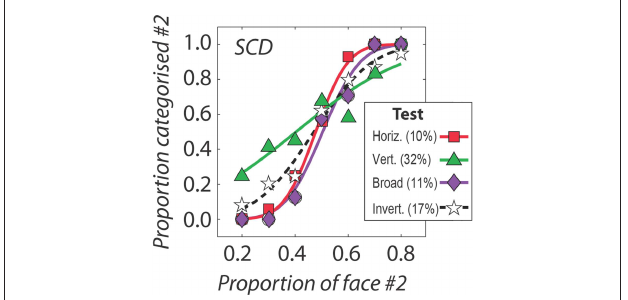
Figure 5 | Psychometric functions are shown for the discrimination of upright/broadband faces (in purple), inverted/broadband faces (in black/ white), horizontally filtered upright faces (in red) and vertically filtered/ upright faces (in green). Identity thresholds - the identity levels eliciting 82% accurate discrimination - are given in